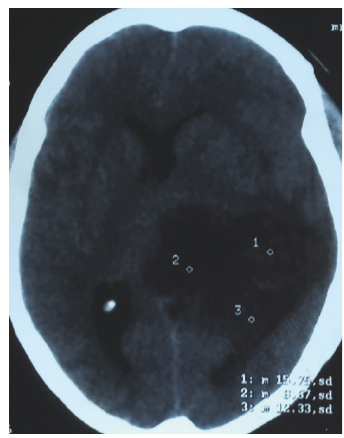
Figure1:BrilliantlyenhancinglesioninleftlateralventricleonMRI. Figure 2: Recurrence of lesion on CT-scan after surgery.